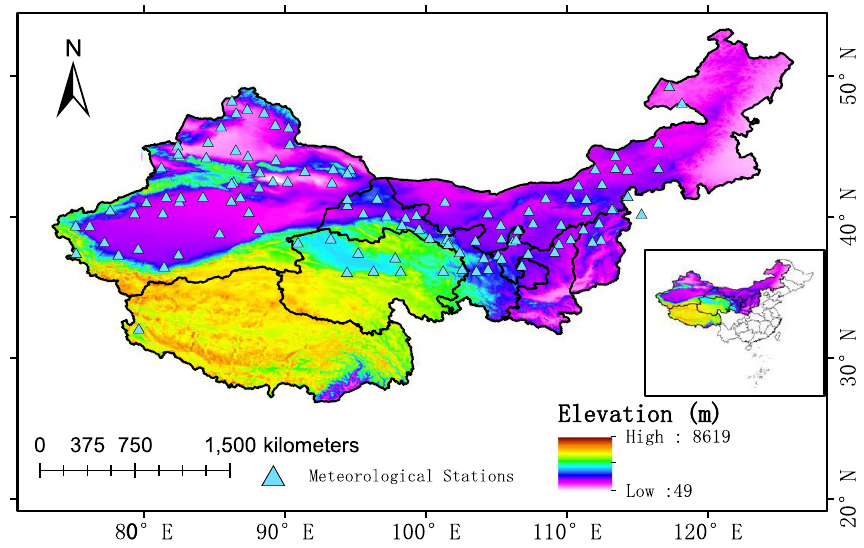
Figure 11. The locations of meteorological stations in arid region of China The map is generated with Arc Map version 10.5 (http:// www. esri. com/ sofwa re/